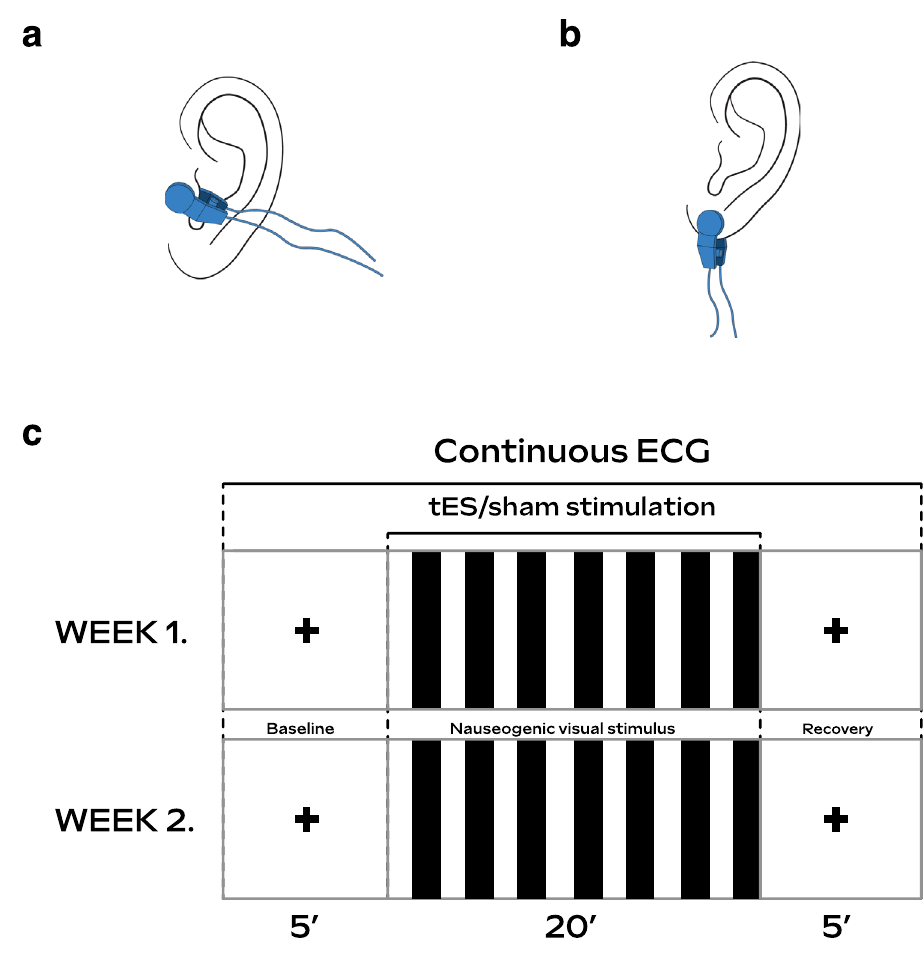
Figure 6. Experimental overview illustrations. (a) The electrode was clipped at the tragus site of the left ear during tES condition. (b) And clipped to the earlobe of the left ear during sham condition. (c) Participants underwent a baseline, nauseogenic visual stimulation and recovery section, respectively in both week 1 (first visit) and week 2 (follow-up visit), separated by 1 week. Electrocardiogram (ECG) signals were recorded continuously from beginning of baseline to end of recovery. Participants were randomly assigned to receive tES or sham in week 1 (first visit) and to receive opposite treatment on follow-up.